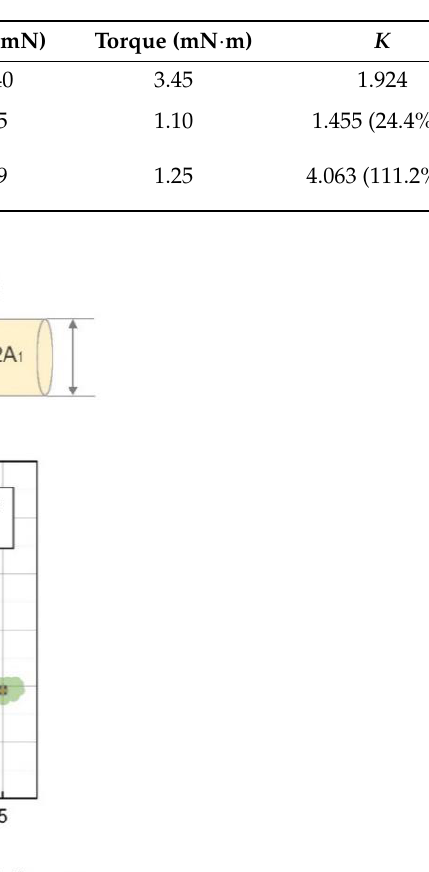
Table 1. The three propulsion performance indexes (thrust, torque, and K ) of three models (basic model, the tapered helical swimmer with a constant pitch, and the tapered helical swimmer with constant helix angle).